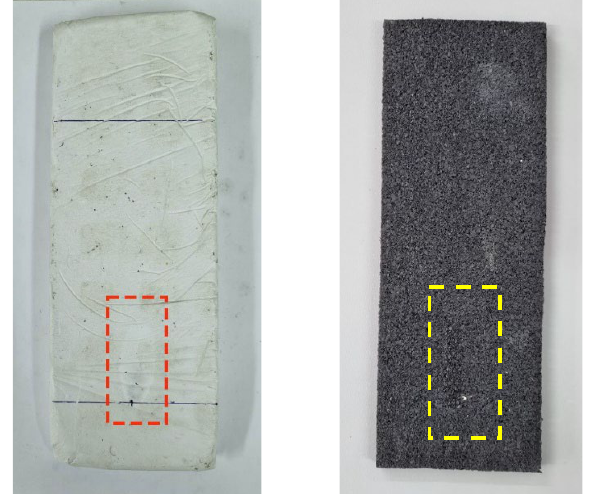
Figure 23. E-0.7-Na-TF and ELT rubber samples after fire